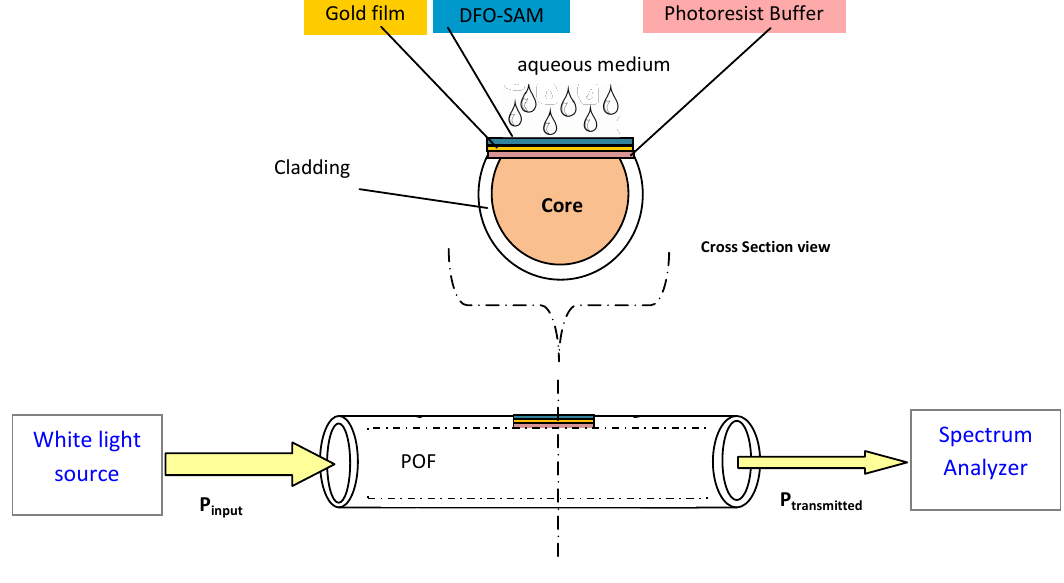
Figure 1. POF chemical sensor based on SPR and experimental